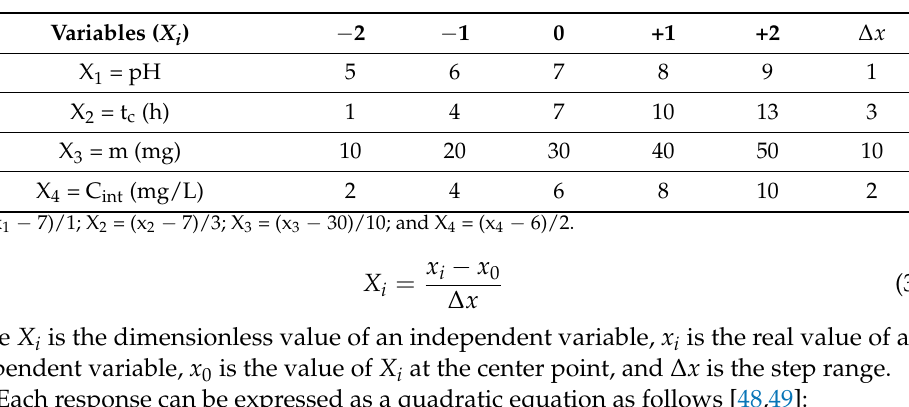
Table 2. Experimental areas of the factors studied in the optimization of PCP adsorption capacity on